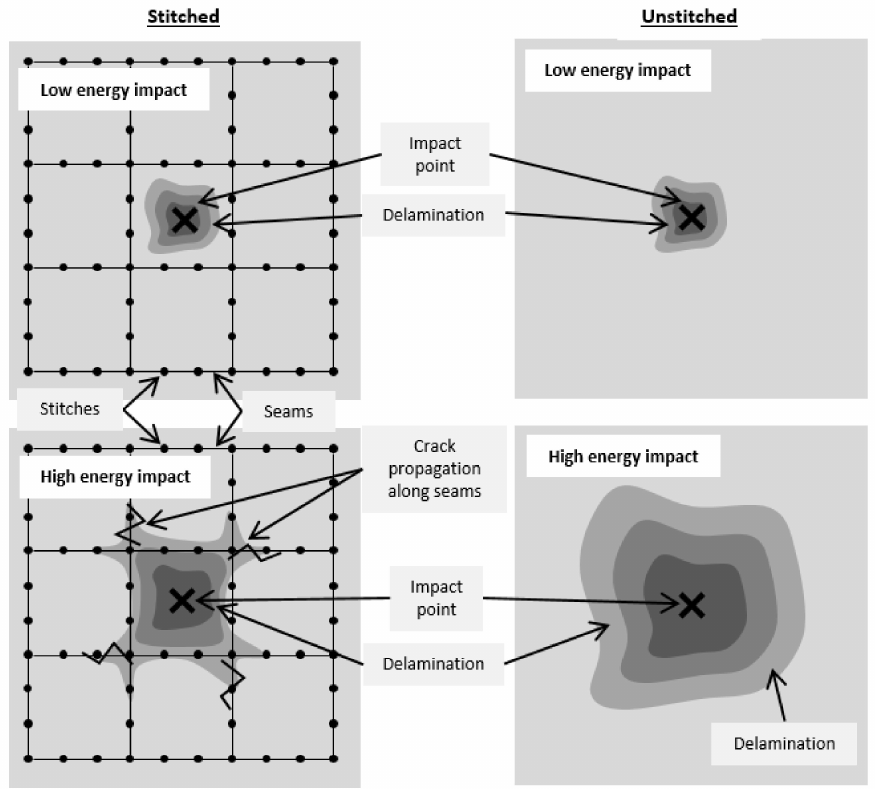
Figure 12. Schematic comparison between the generated damage in the stitched ( left ) and unstitched laminates ( right ), impacted at low ( top ) and high energy ( bottom